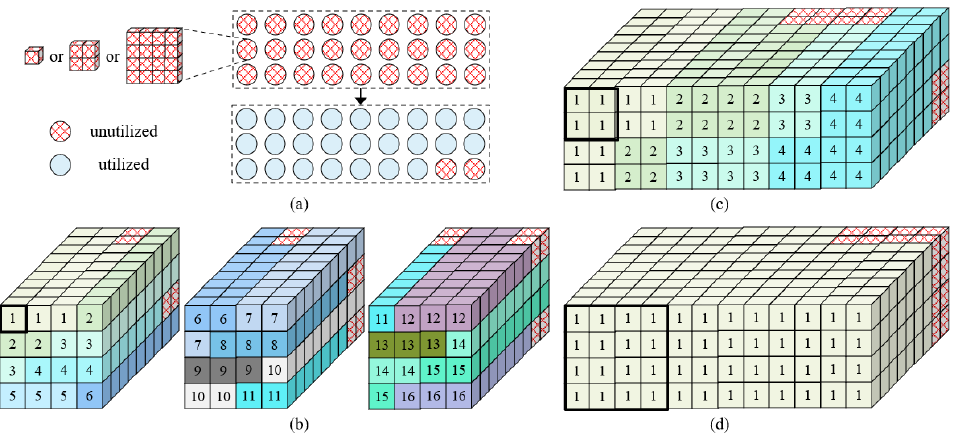
Figure 9. Data-mapping for 5 × 5 convolution. ( a ) Utilization analysis. ( b ) Case for 4-bit, 3 macros compute 16 convolutions with utilization 92.6%. ( c ) Case for 8-bit, 3 macros compute 4 convolutions with utilization 92.6%. ( d ) Case for 16-bit, 3 macros compute 1 convolution with utilization